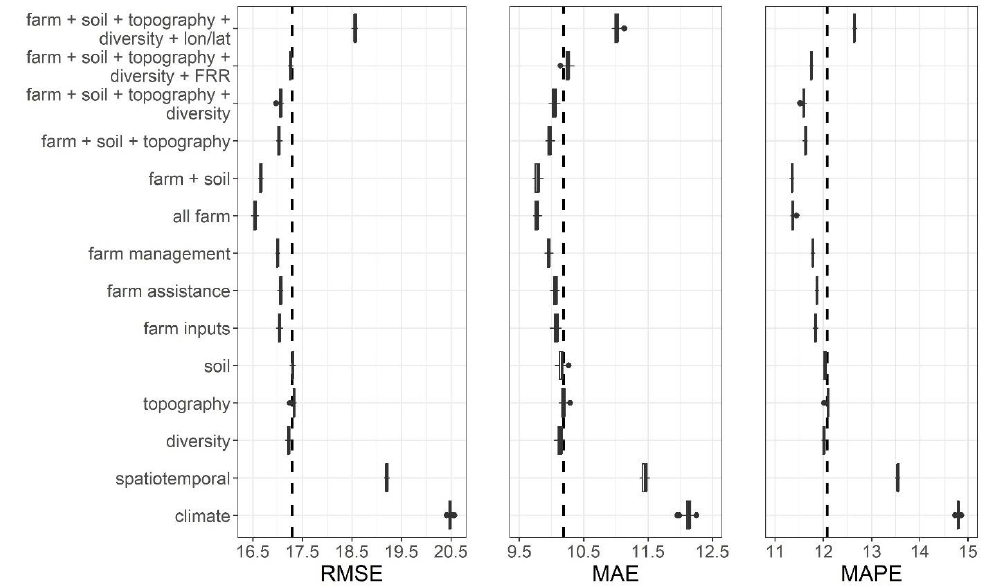
Figure 3. Comparison of change in the 5-fold cross validation accuracy when variable groups are removed from the model. The dashed line represents the median accuracy metric for the model including all variables. The boxplots represent the range of errors observed in 50 replications of cross validation. Error metrics include the root mean square error (RMSE), the median absolute error (MAE), and the mean absolute percentage error (MAPE).